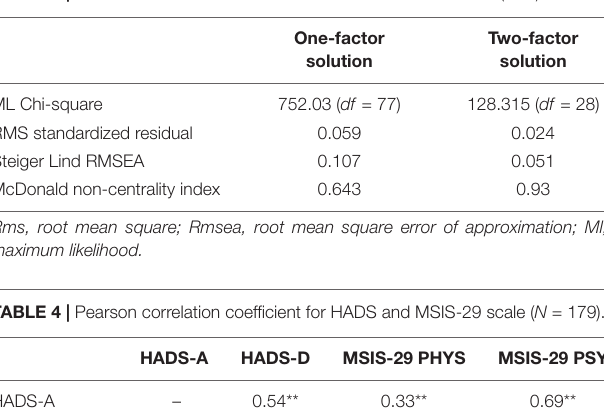
TABLE 3 | Fit indices for one-factor and two-factor model of HADS (CFA).